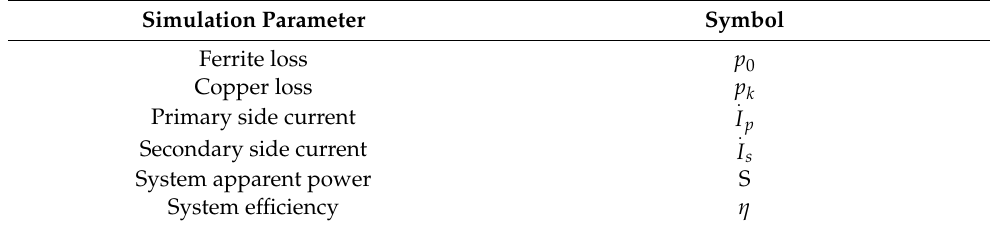
Table 7. Symbols representing the simulation parameters.